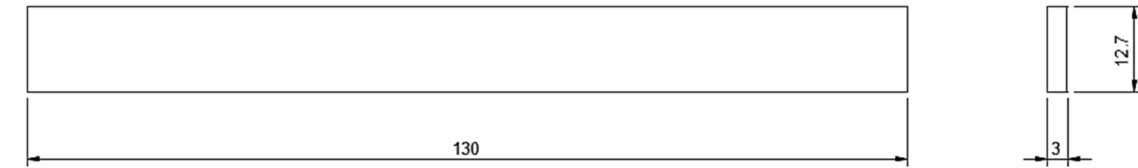
Figure 12. ASTM D790 specimen for flexural testing [23].